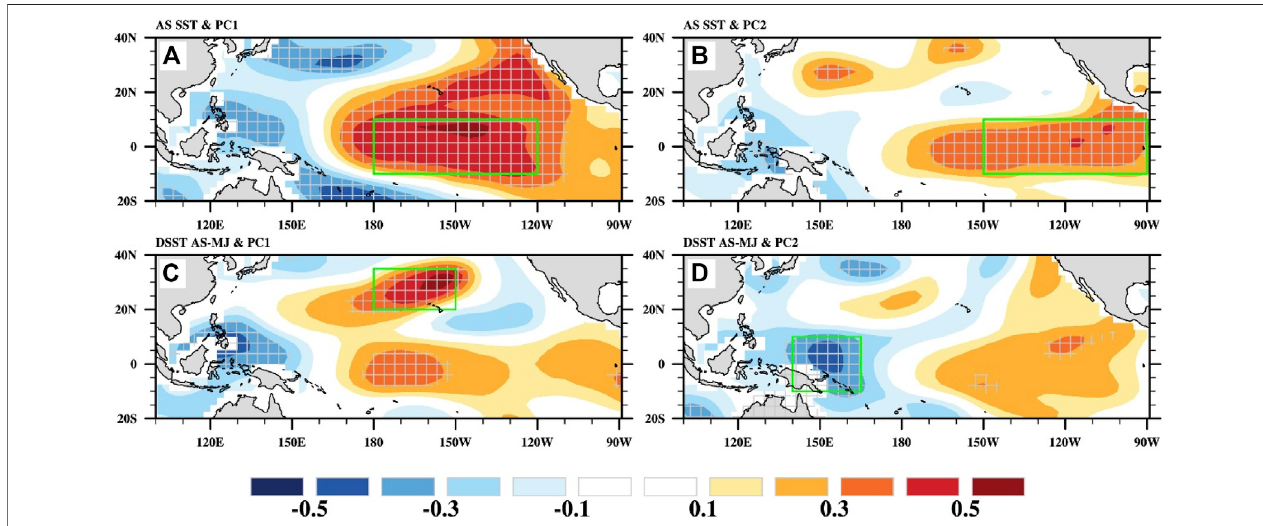
FIGURE 6 | Correlation map between PC1 and (A) August – September mean SST and (C) SST tendency from May – June to August – September during 1965 – 2018. (B) and (D) are the same as (A) and (C) but for PC2. Hatched areas denote regions with correlation coef fi cients that are signi fi cant at the 90% con fi dence level. The green boxes denote de fi nition areas for the selected